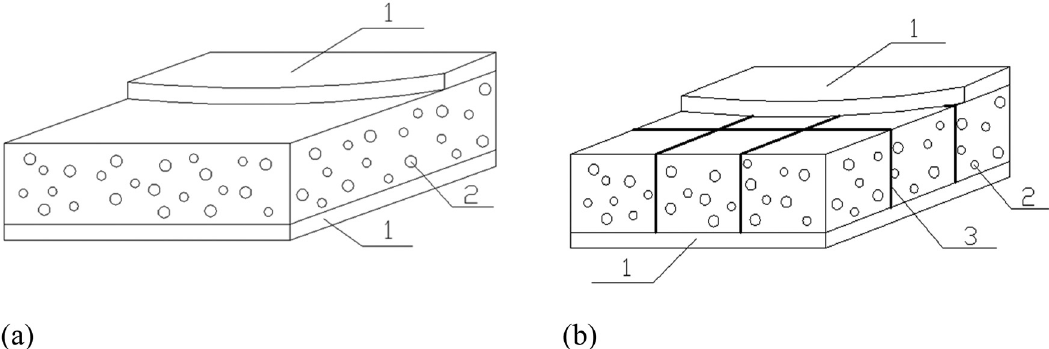
Figure 1: Diagram of syntactic foam sandwich panels ( 1. GFRP sheet faces, 2. Syntactic foam core, 3. Lattice webs ) . ( a ) Sandwiches with GFRP sheet faces. ( b ) Sandwiches with GFRP skins and lattice webs.